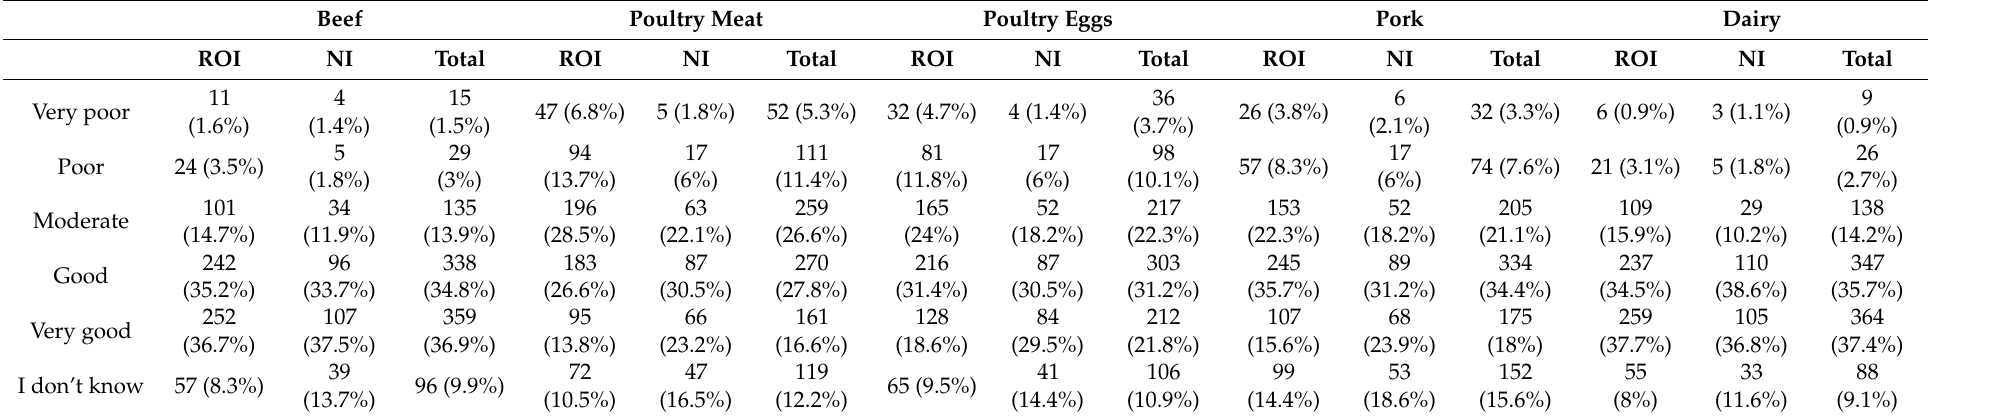
Table 2. Survey-based consumer perceptions ( n = 972) of farm animal welfare in the Republic of Ireland (ROI) and Northern Ireland (NI) across five production sectors a .